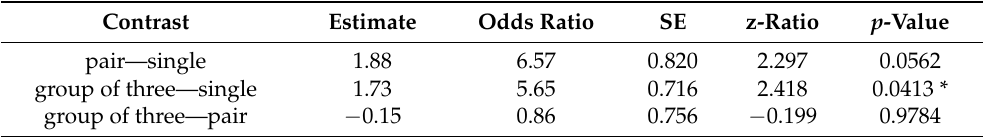
Table 4. Results for the pairwise comparisons in the logistic regression model with lesions of kits as dependent variable. Contrast